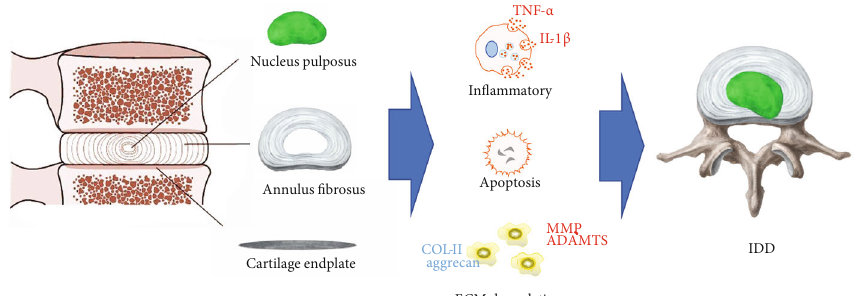
Figure 1: The component of intervertebral disc and the major pathologic process of degeneration.